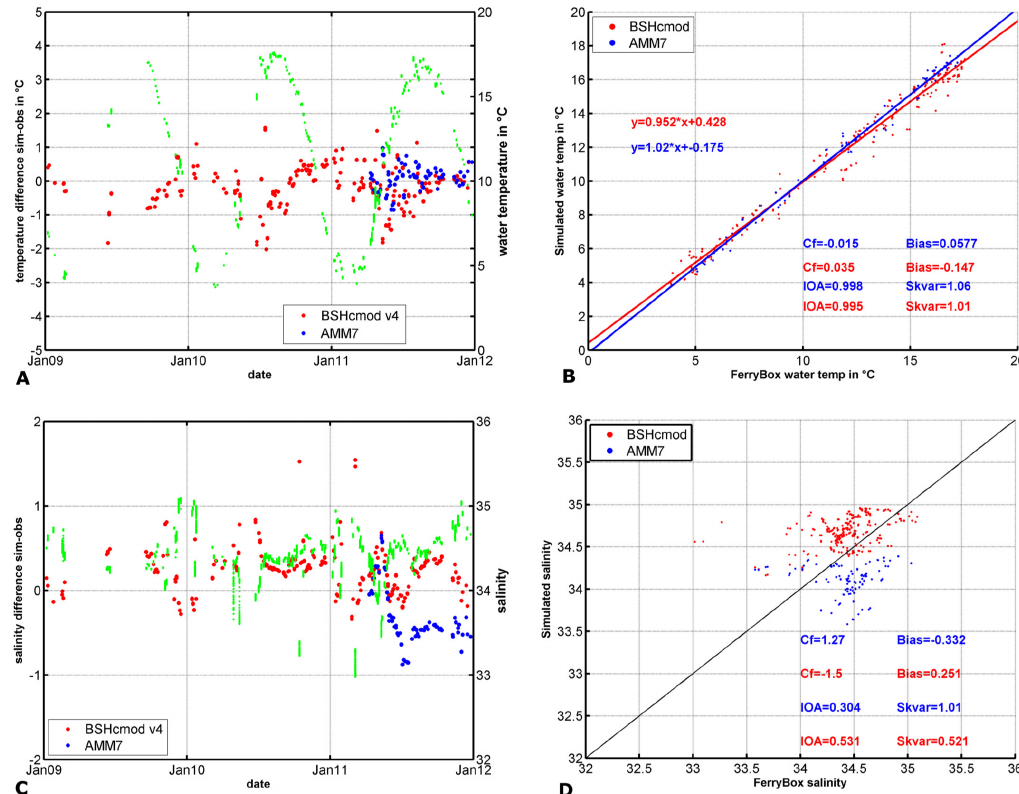
Figure 10. Upper panels: time series of temperature differences and absolute FerryBox values (in green) (a) and scatterplot of temperatures (b) of FerryBox measurements of TorDania and Lysbris and model results at the Oyster Ground (p2). Lower panels: time series of salinity difference and absolute FerryBox values (in green) (c) and scatterplot of salinity (d) of FerryBox measurements of TorDania and Lysbris and model results at the Oyster Ground